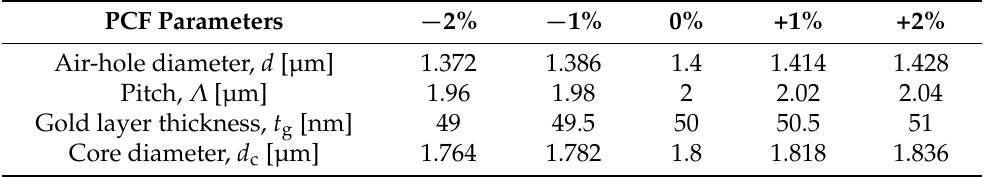
Table 4. Five-level Four Parameters ( ± 2% variations) and Their Values for DoE CCD Analysis.